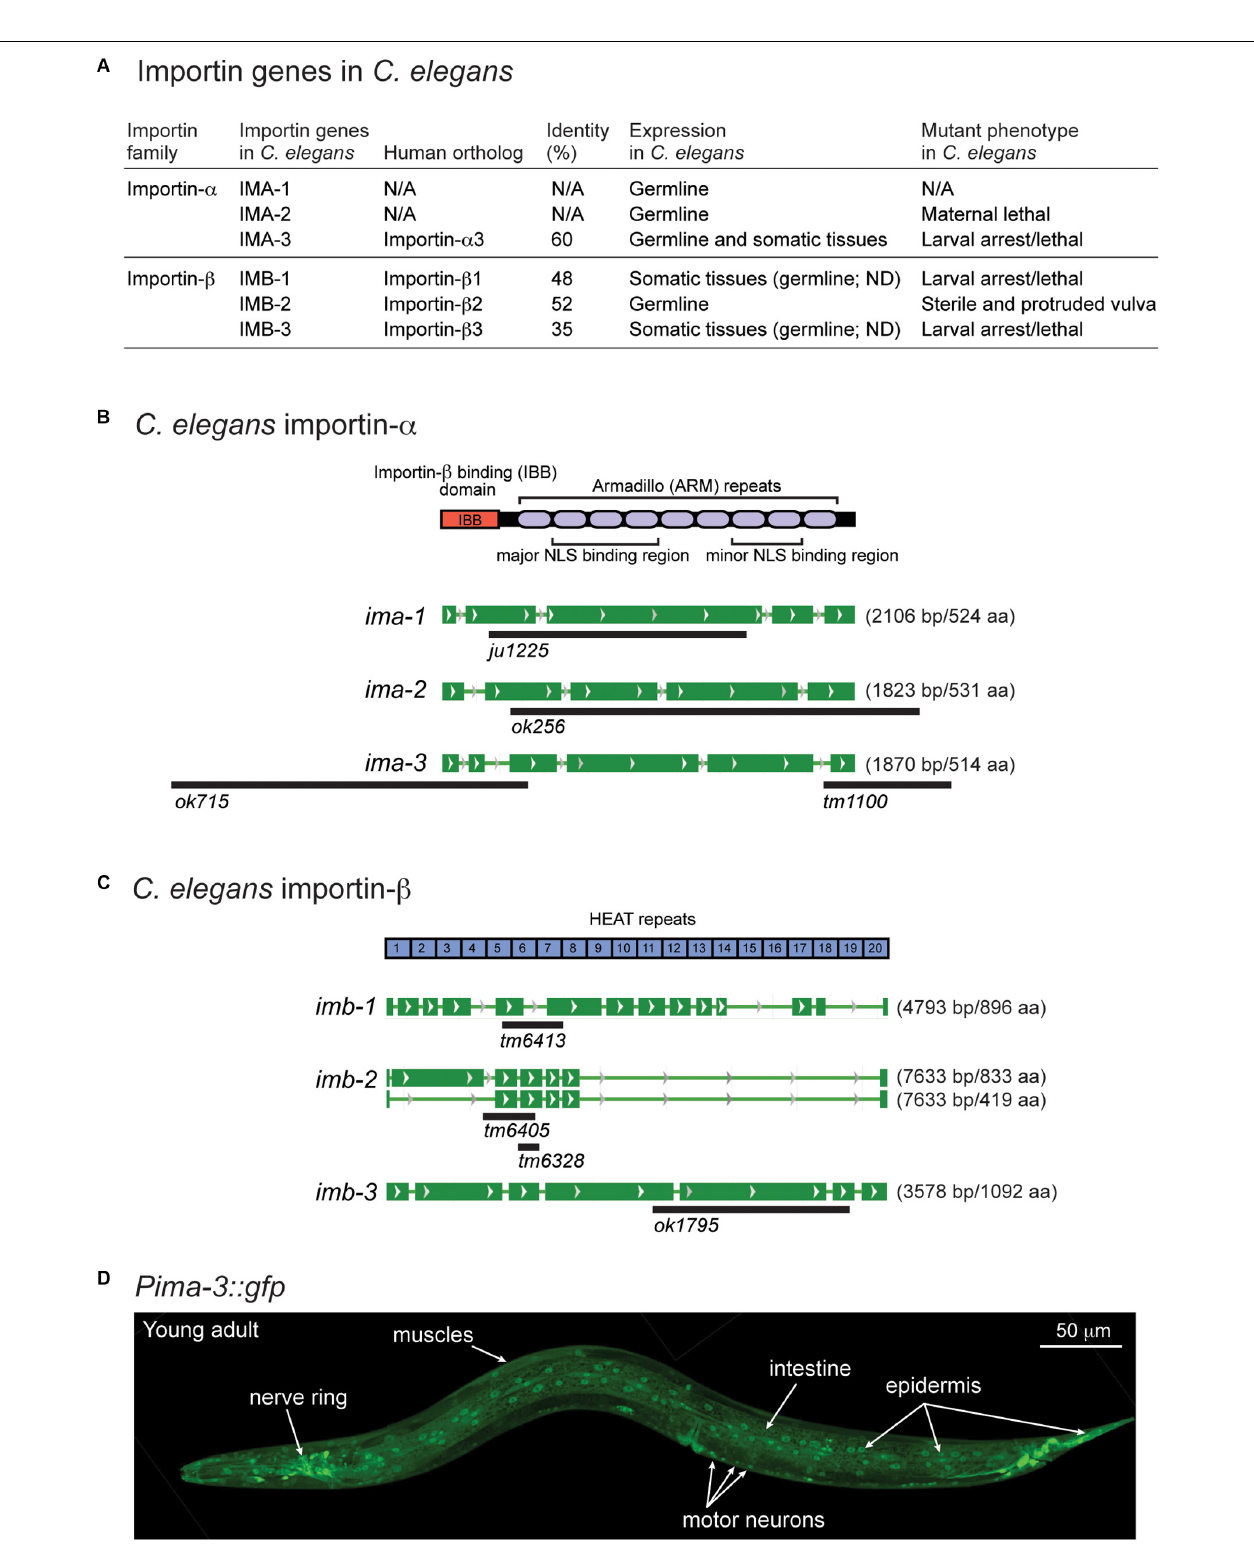
FIGURE 4 | ima-3 is expressed in many somatic tissues. (A) A summary table of C. elegans importins. (B) C. elegans importin- α genes and available mutations. (C) C. elegans importin- β genes and available mutations. (D) A representative confocal image of C. elegans importin- α 3/ ima-3 expression ( Pima-3::gfp) in a young adult